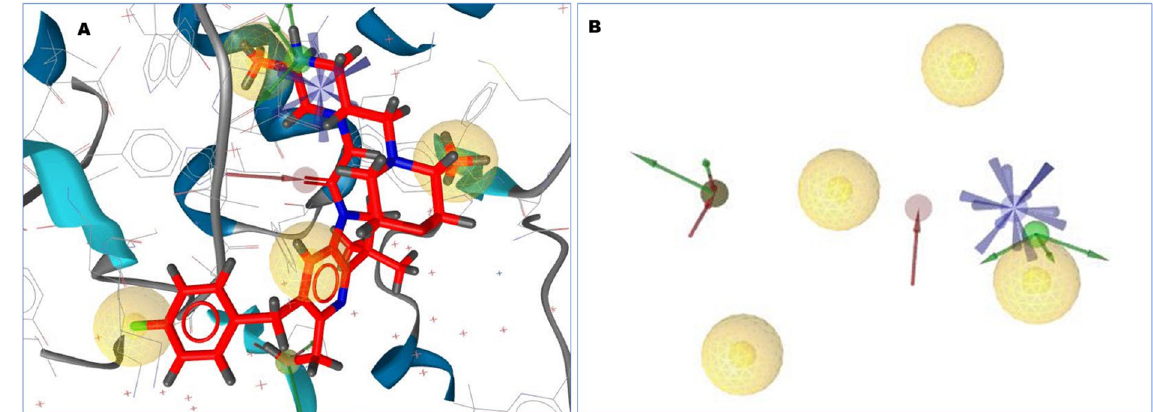
Figure 1. ( A ) The 3D structure-based pharmacophore model of XIAP protein in complex with 46781908 (CID) ligands derived from the X-ray derived crystal structure of XIAP protein (PDB ID: 5OQW). ( B ) Several pharmacophore features were generated after complex interaction, four yellow spherical shapes indicating hydrophobic interaction, one blue star shape depicting the positive ionizable with tolerance 2, three red colors arrow and spherical shapes indicating H bond acceptor having tolerance 1.5, five hydrogen bond donors represented by green spherical or arrow shape have been identified within the protein–ligand complex interaction. 15 exclusion volume, which were generated during pharmacophore modeling has not showed in this schematic presentation.